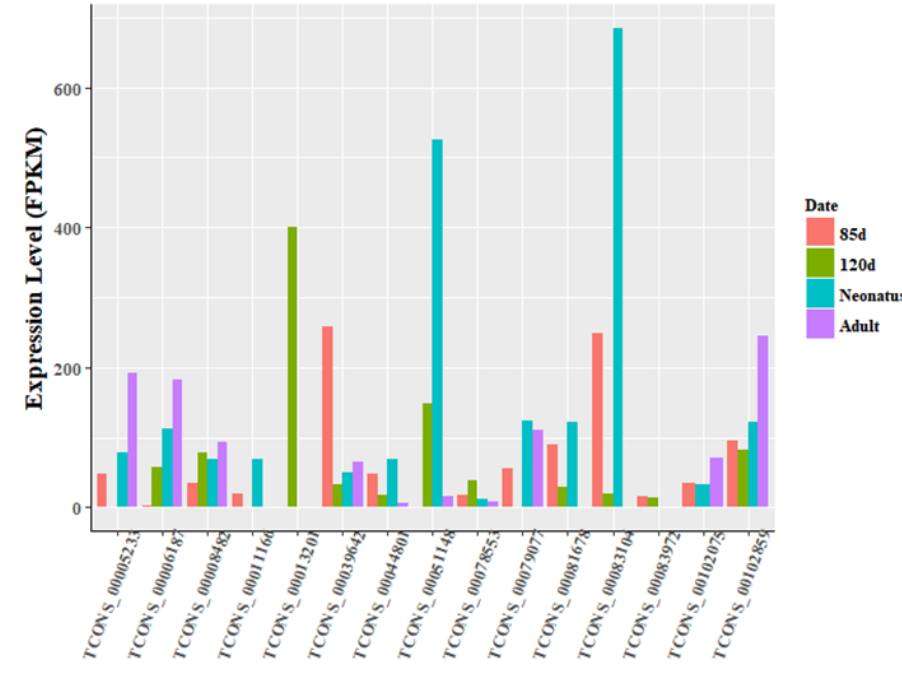
Figure 6. Expression level of differentially expressed lncRNAs at all stages in Texel. There were 15 lncRNAs that were identified to be differentially expressed in all stages. The expression levels of lncRNA transcripts were estimated using FPKM. In particular, the expression of TCONS_00006187 increased gradually with development in Texel sheep. In contrast, TCONS_00013201 was expressed only in Texel 120-day-old fetus. Moreover, the expression level of TCONS_00083104 in Texel 85-day-old fetus and neonate was higher than at other stages. Finally, TCONS_00044801, TCONS_00008482 and TCONS_00102859 were expressed steadily at all four stages in Texel sheep. While the 6 lncRNAs we mentioned above show different expressed characters in Ujumqin sheep.